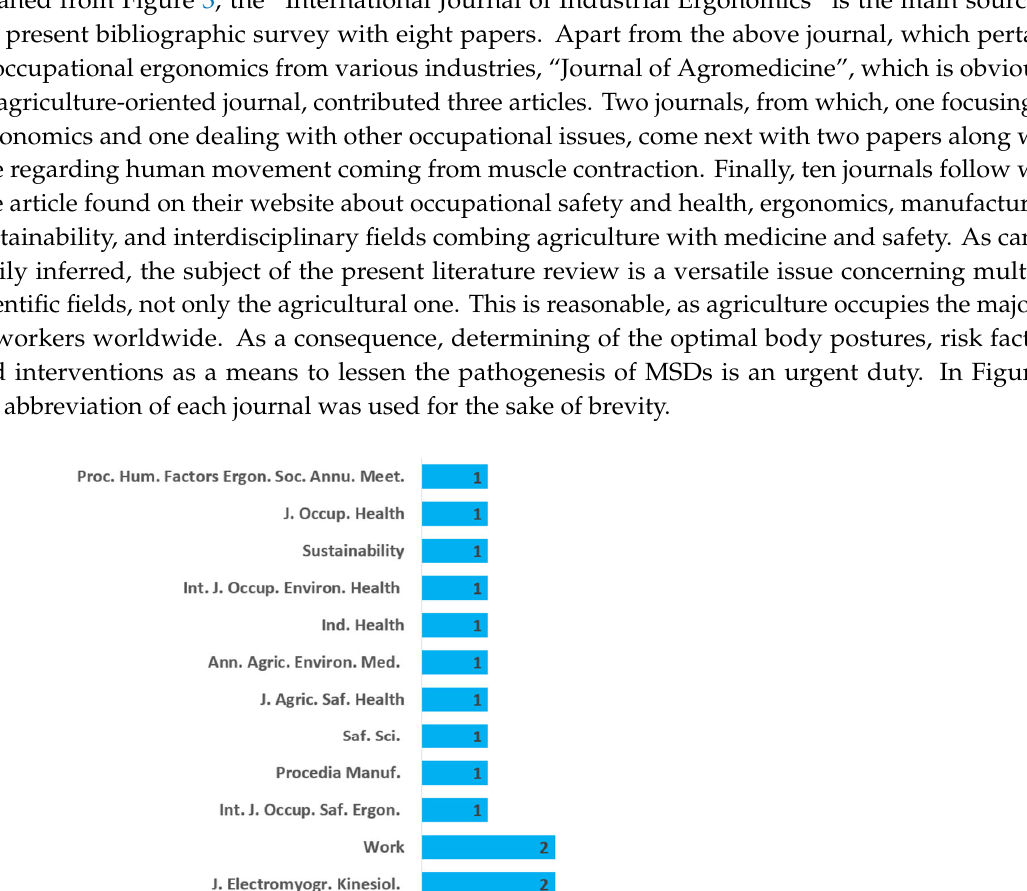
Figure 4. Keyword information clustering of the relevant papers. 3.2. Literature Survey In this fashion, it should be clarified that some manual tasks may also contain other tasks. However, each task was analyzed in a different subsection for the sake of better identifying the origin of the risk factors. 3.2.1. Harvesting Harvesting is defined as the procedure of gathering crops from the fields and putting them to secure sites for storage, processing, and consumption. In small farms (especially in developing countries), greenhouses, and several horticultural crops, such as vegetables, minimal mechanization takes place [8]. On large farms, however, harvesting is carried out with expensive and sophisticated machinery, such as modern combine harvesters. In this subsection, the studies dealing with MSDs coming from manual harvesting are briefly analyzed. According to our survey, 13 journal papers were found to be associated with this subject.